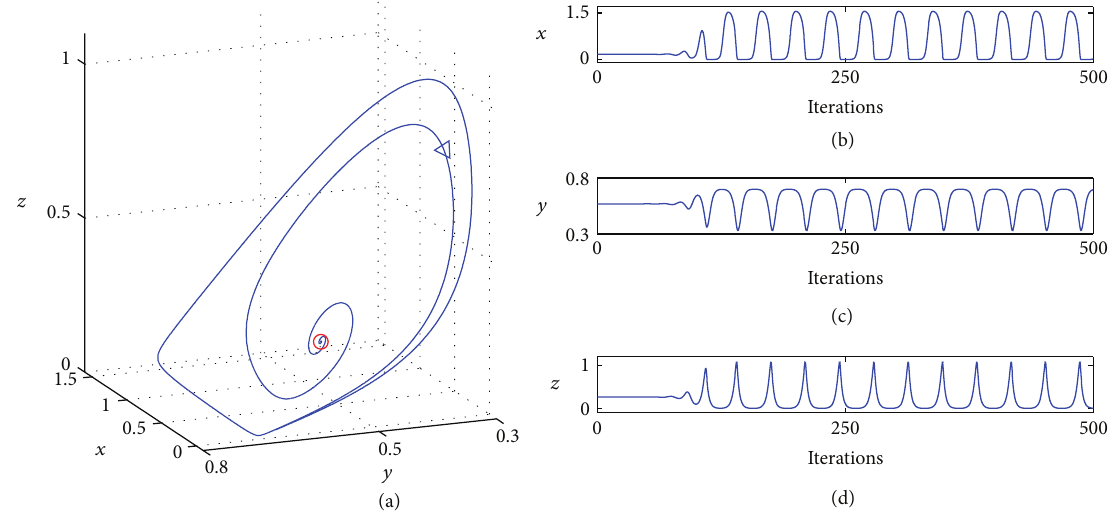
Figure 3: (a) A phase portrait of system (1) with initial condition (0.171, 0.567, 0.265) and (b)–(d) time series for 𝑥 1 (𝑡), 𝑥 2 (𝑡) , and 𝑦(𝑡) , respectively, when 𝑎 1 = 0.8, 𝑏 1 = 0.5, 𝑎 2 = 0.7, 𝑏 2 = 1, 𝑐 = 0.2, 𝑑 = 0.5, 𝑒 1 = 0.9, 𝑒 2 = 0.3, 𝛼 = 1.3 , and 𝛽 = 0.5